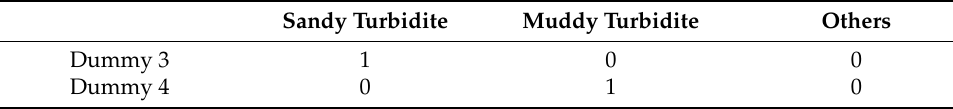
Table A2. Rule of dummy variables on geology.